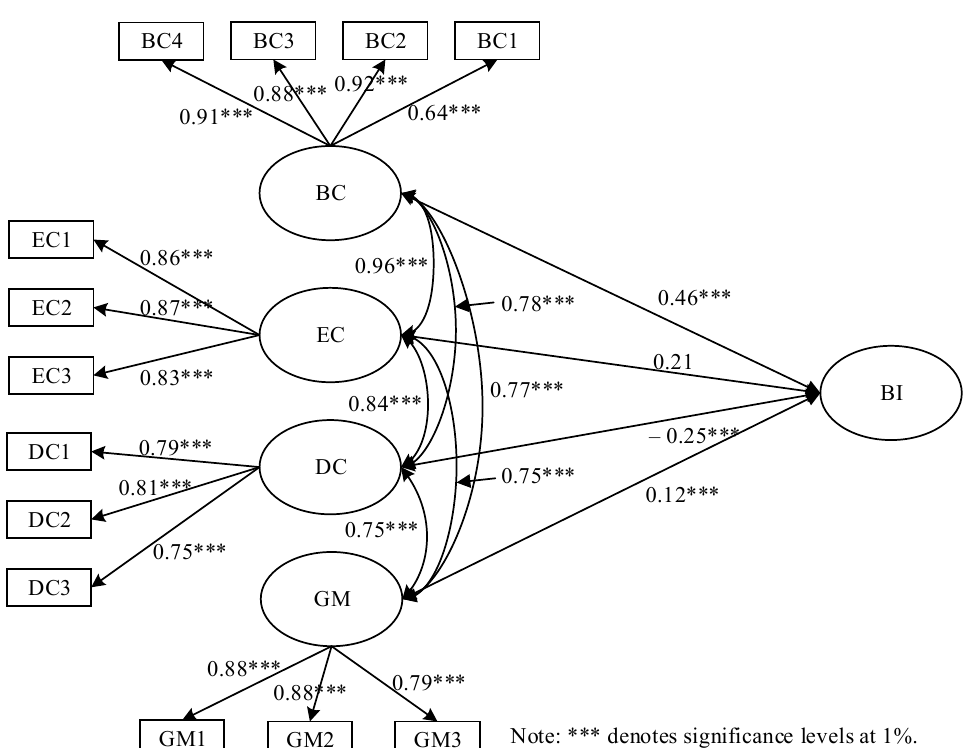
Figure 3. Results of structural equation model regression.